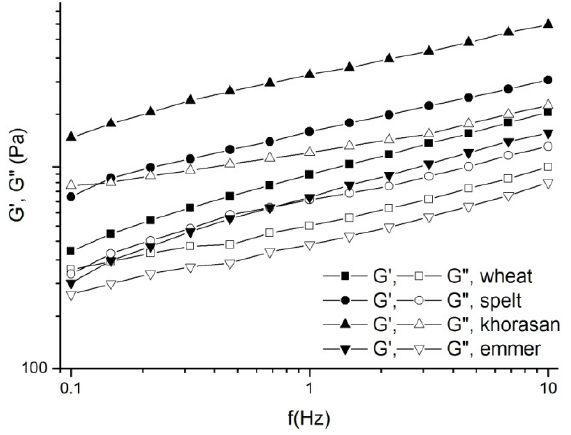
Figure 1. Mechanical spectra of mature wheat, emmer, khorasan and spelt sourdough.